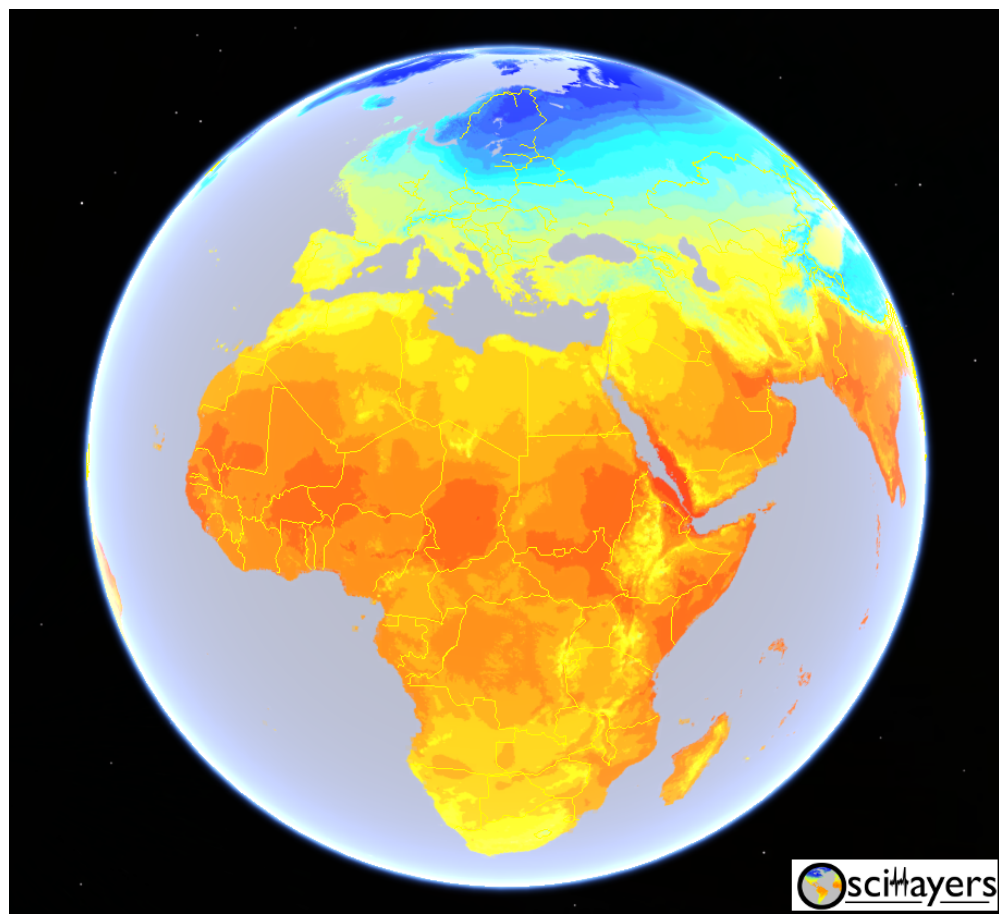
Figure 8. Example layer (Bio1; the first out of 539 time points) of the Oscillayers paleo-bioclim dataset (Bio1–Bio19) spanning the Plio-Pleistocene (the last 5.4 Myr) in steps of 10 kyr plotted in